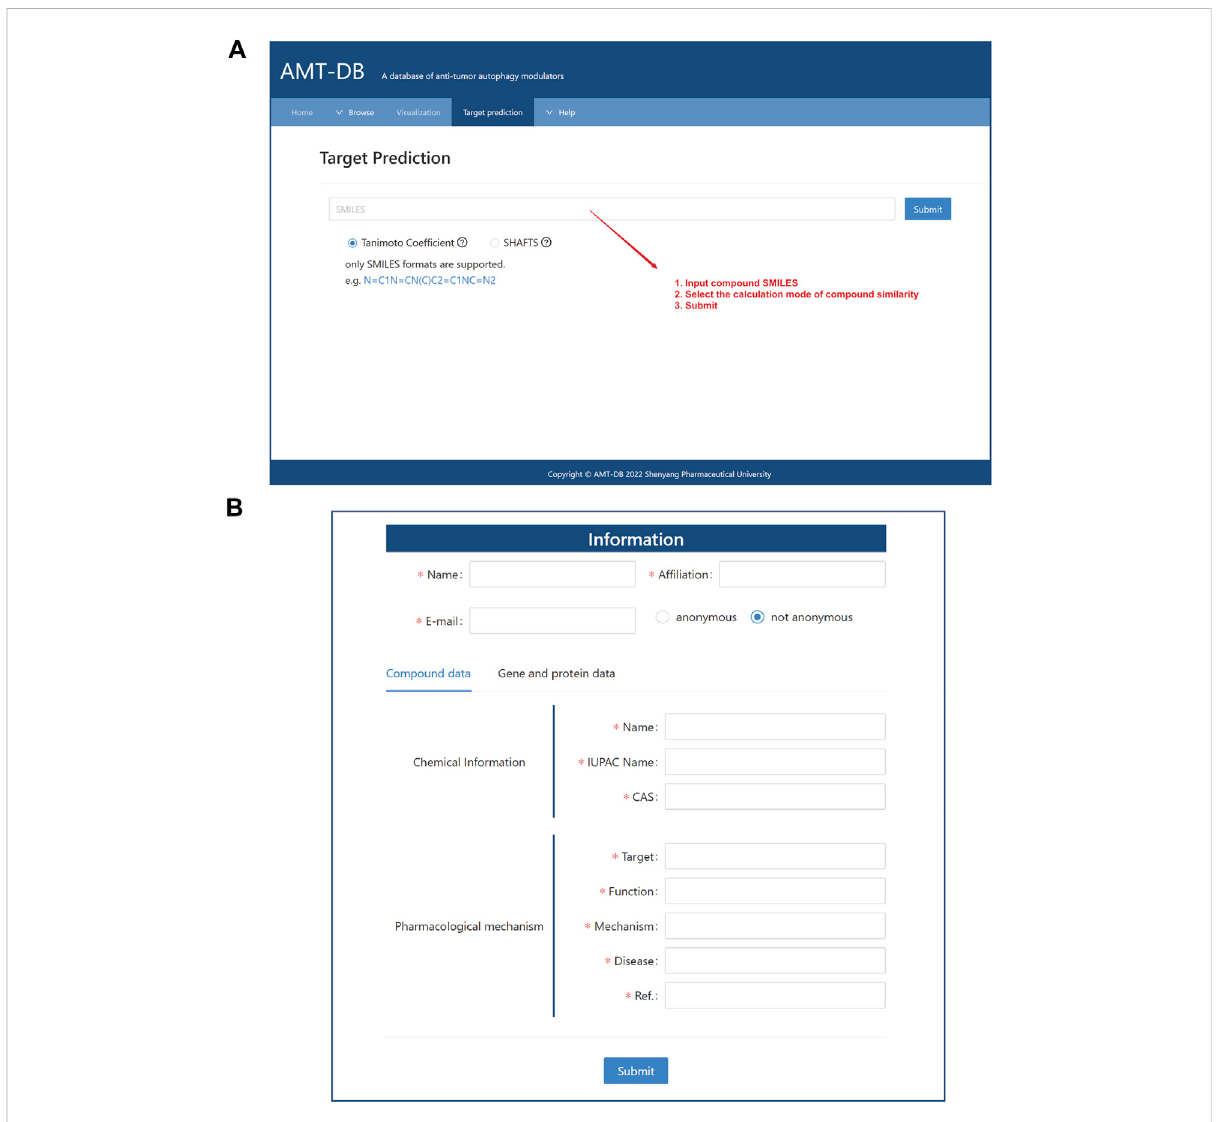
FIGURE 4 Web interface. (A) Target prediction; (B) The submit